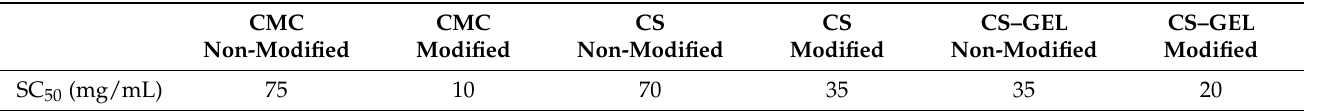
Table 2. SC 50 (mg/mL) values for the individual biopolymers and the enzymatically modified biopolymers with ferulic acid, according to the DPPH protocol. (The standard deviation was less than 5% in all